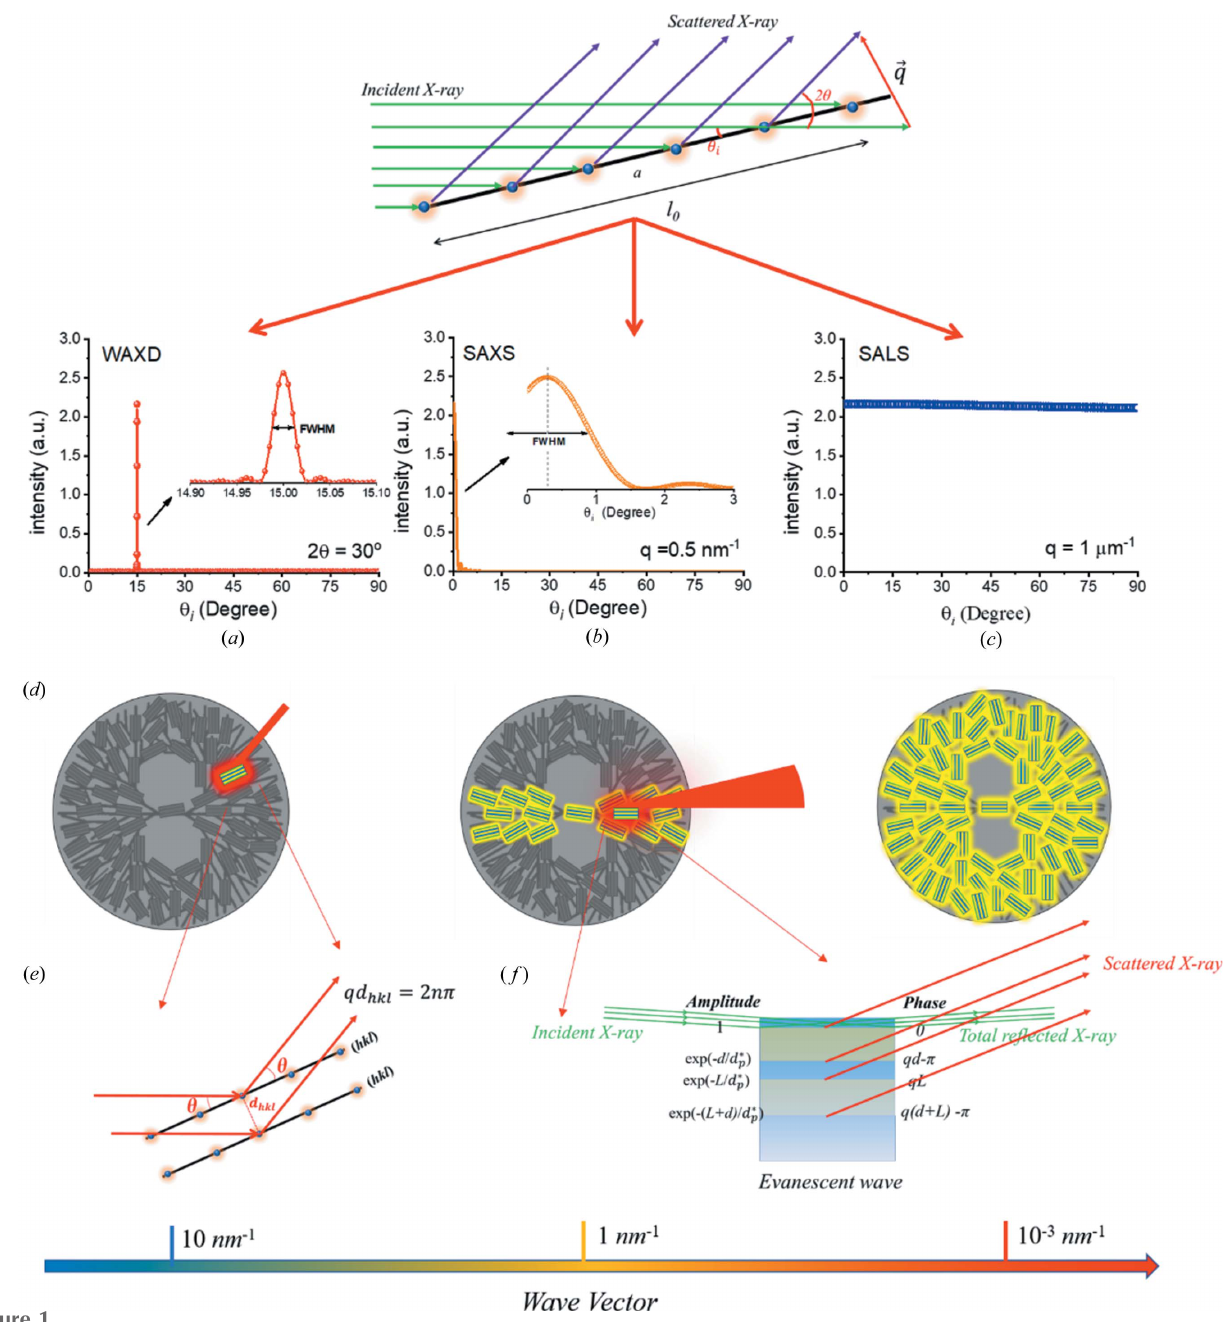
Figure 1 The influence of incident angle on the scattering intensity of a crystal plane at ( a ) 2 (cid:4) = 30 (cid:3) , ( b ) q = 0.5 nm (cid:5) 1 and ( c ) q = 1 m m (cid:5) 1 . Insets in ( a ) and ( b ) show the change of scattering intensity near (cid:4) i = 15 (cid:3) and q = 0 nm (cid:5) 1 , respectively. ( d ) Illustrations for lamellar crystals, which have significant contributions to scattering in WAXD, SAXS or SALS. ( e ) The diffraction mechanism in WAXD. ( f ) An illustration of the scattering of the interfacial electrons involved in the evanescent